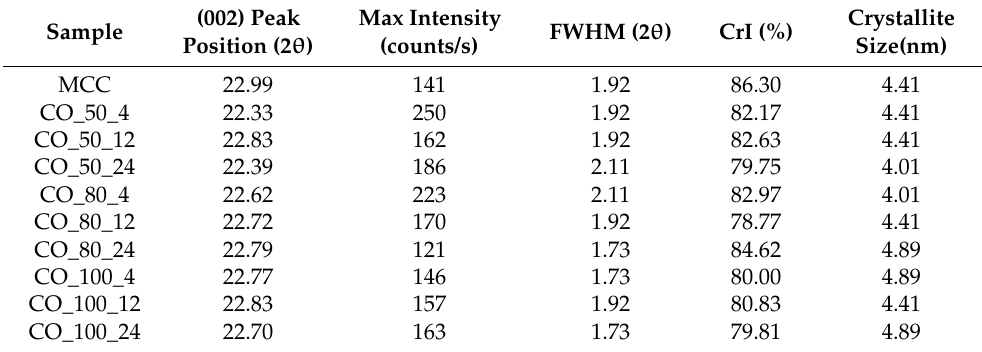
Table 2. The (002) peak position, maximum intensity, FWHM, crystallinity index, and crystallite size of cellulose and cellulose